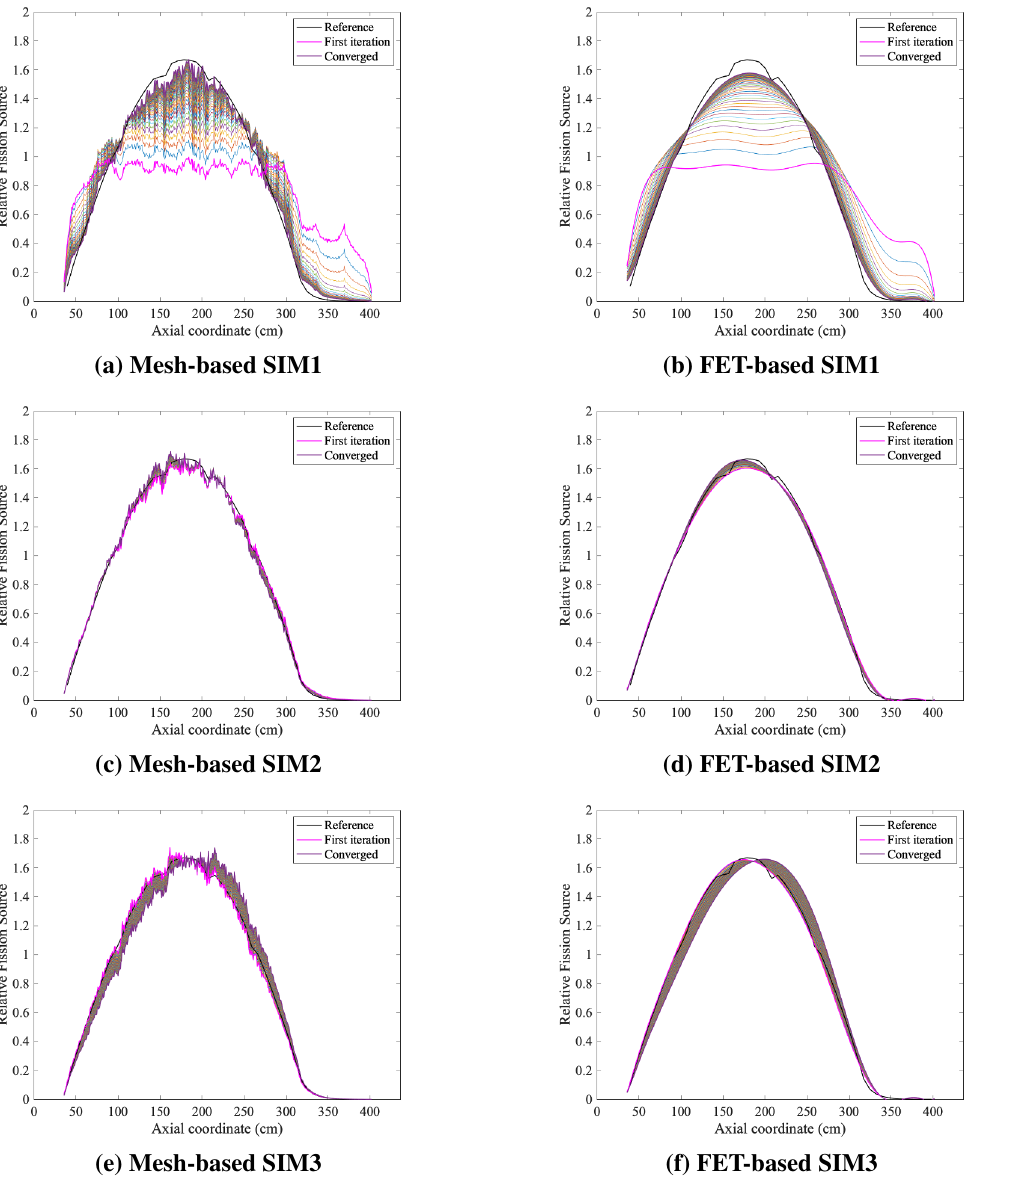
Figure 2: Axial fission source distribution in the single assembly-case. (Coloured curves: outer iterations of response matrix solver; black curve: Monte Carlo converged